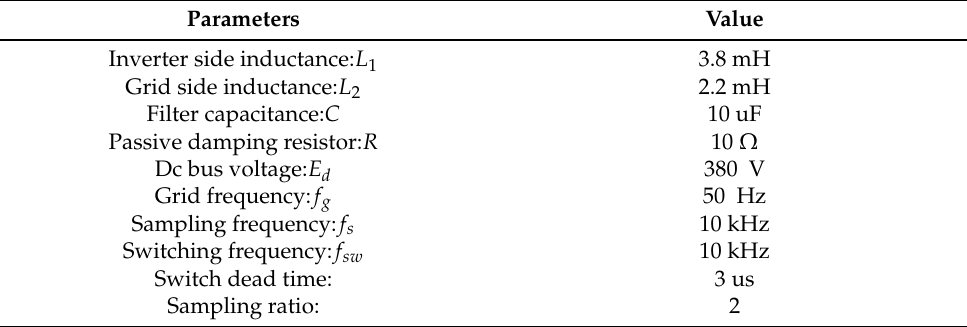
Table 1. Parameters of the LCL-type single-phase grid-connected